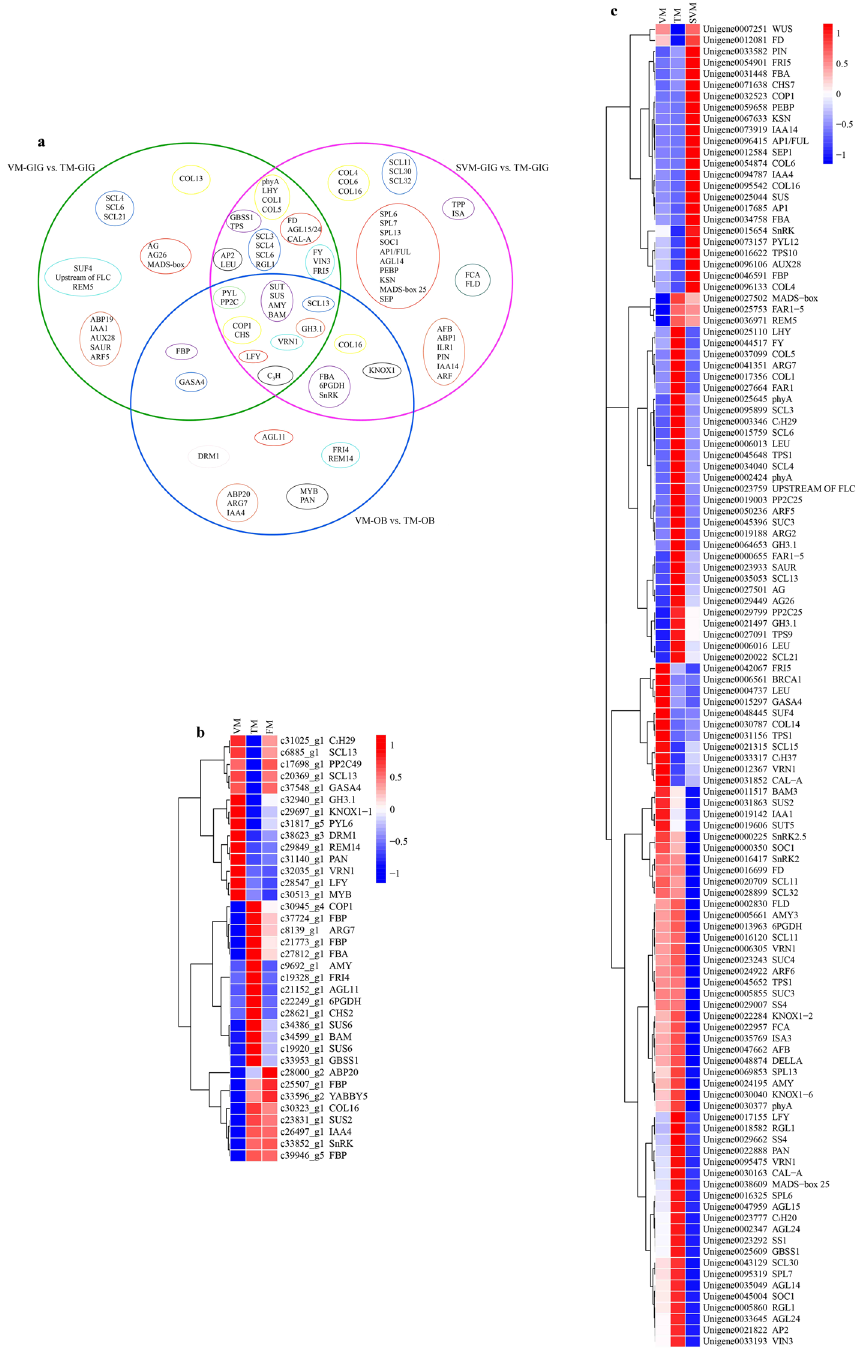
Figure 3. The overview of DEGs was identified between different comparisons of OB and GIG, respectively. ( a ) A Venn diagram showing the candidate floral DEGs commonly or individually belonging to each comparison of GIG and OB. Big green circle represents DEGs in the VM-GIG vs. TM-GIG comparison; big rose-red circle represents DEGs in the SVM-GIG vs. TM-GIG comparison; big blue circle stands for DEGs in the VM-OB vs. TM-OB comparison. Small yellow, cyan-blue, purple, light blue, orange-red, black, red circles indicate DEGs involved in photoperiod, vernalization, sugar metabolism, GA, auxin pathways, TFs, floral integrators, respectively. ( b ) Hierarchical clustering analysis of key floral candidate DEGs during floral transition process in OB. ( c ) Hierarchical clustering analysis of key floral candidate DEGs in different developmental stages of GIG. Data for gene expression levels were normalized by Z-score. Red and blue colors represent up- and down- regulated genes,